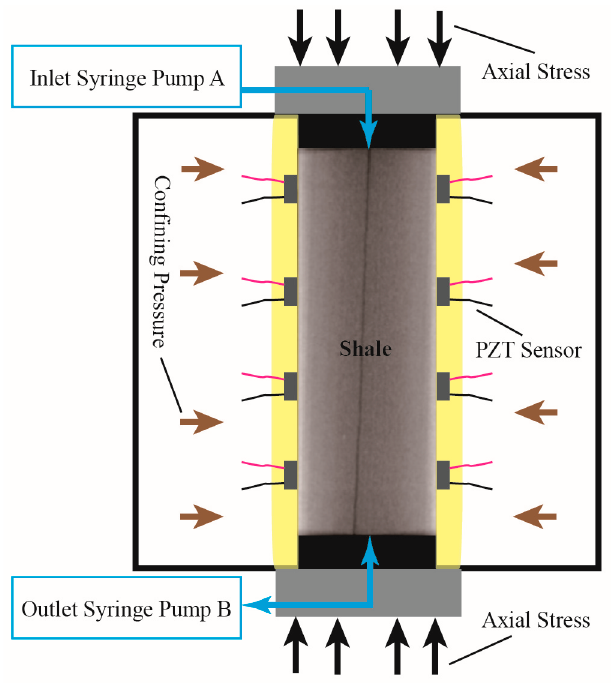
Figure 4. Schematic of the experimental setup for P- and S-wave velocity and attenuation measurement under a triaxial compression conditions.